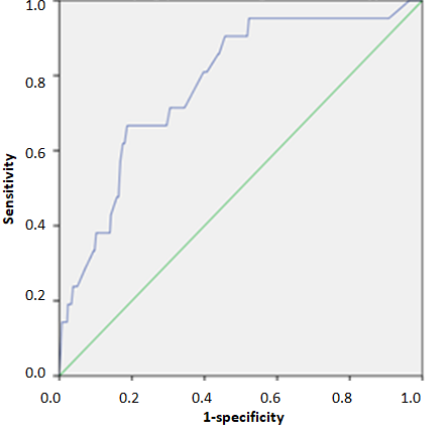
Figure 3. ROC Curve for identifying individuals with grade 2 and 3 hypertension.